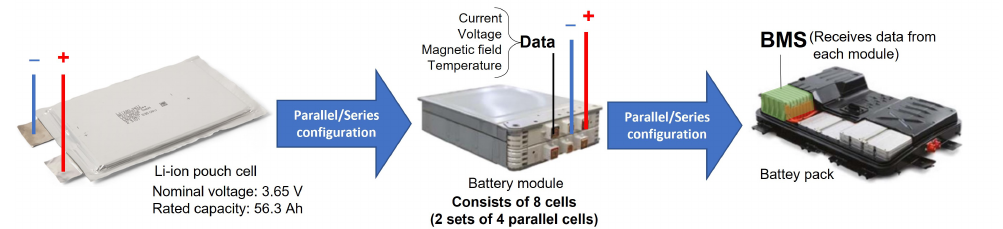
Figure 1. Overview of an EV battery pack. In each module, key parameters, including the magnetic field, are measured for each cell, and the generated data are then fed to the